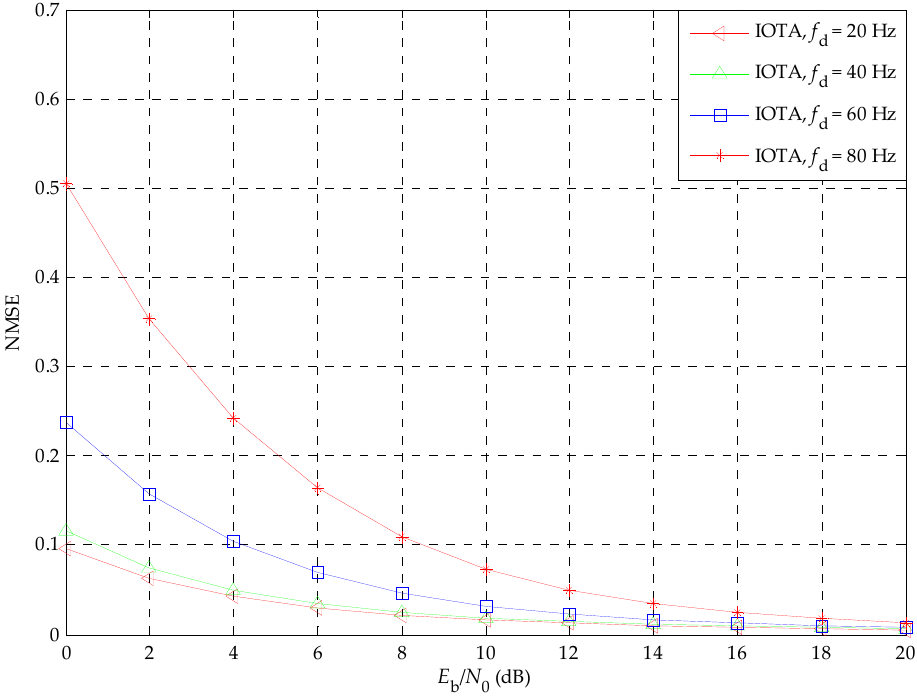
Figure 5. Normalized minimum square error (NMSE) performance of the OFDM/OQPSK system over Rayleigh fading channels with Doppler spread of 20, 40, 60, and 80 Hz.